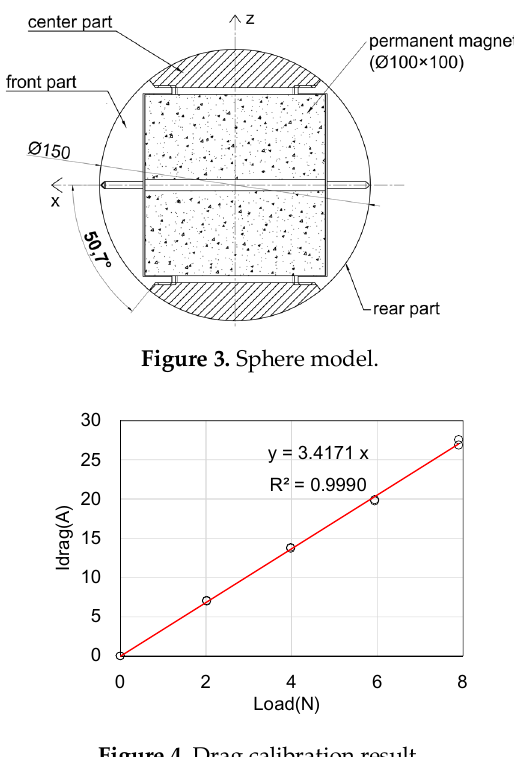
Figure 4. Drag calibration